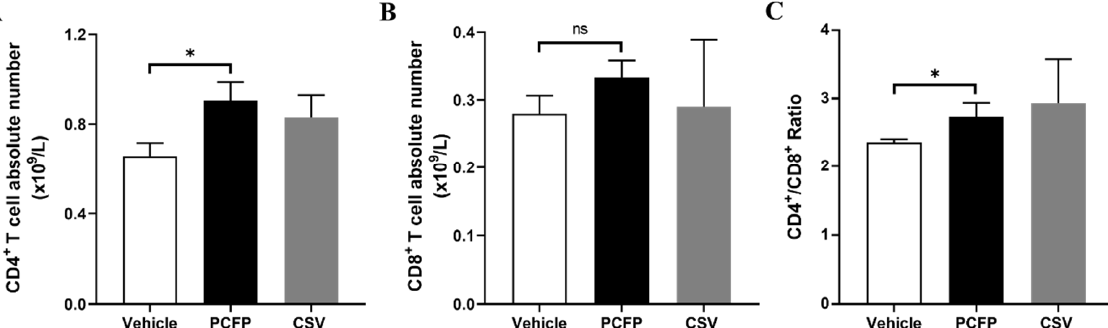
Figure 4. FACS analysis of T lymphocytes in the peripheral blood of immunized mice. ( A , B ) Absolute numbers of peripheral CD4+ T and CD8+ T cells were analyzed by flow cytometry and cell counting. ( C ) The ratio of CD4+ T cells to CD8+ T cells was analyzed. The data are shown as means ± SD and were analyzed using Student’s t-test. * p < 0.05 was considered statistically significant. ns, no statistical difference.